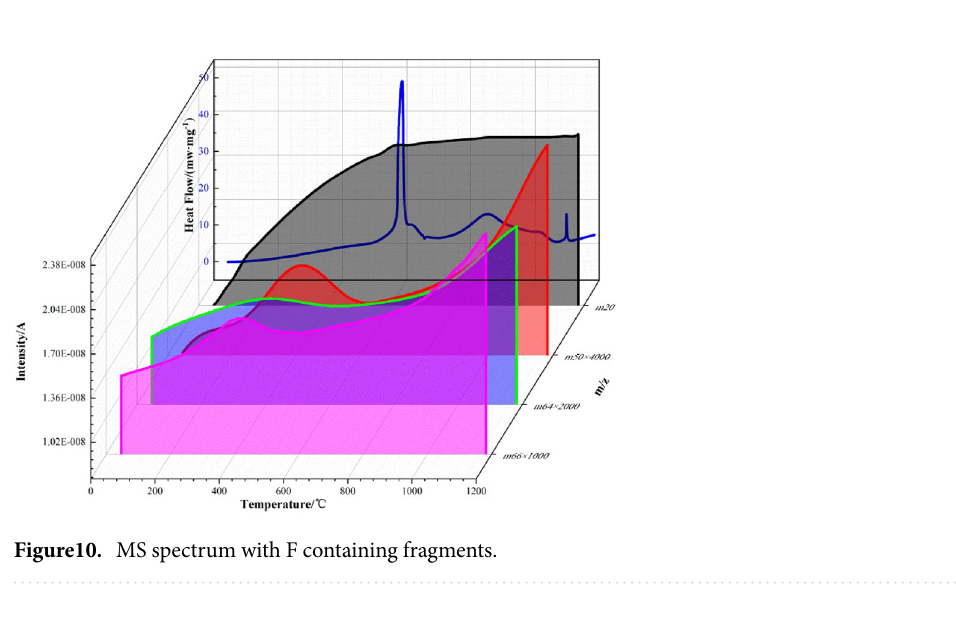
Figure 9. MS spectrum with O containing fragments.